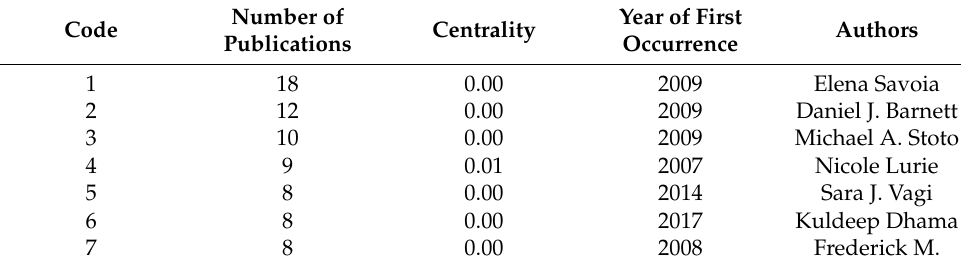
Table 1. The top 7 authors in terms of publications.